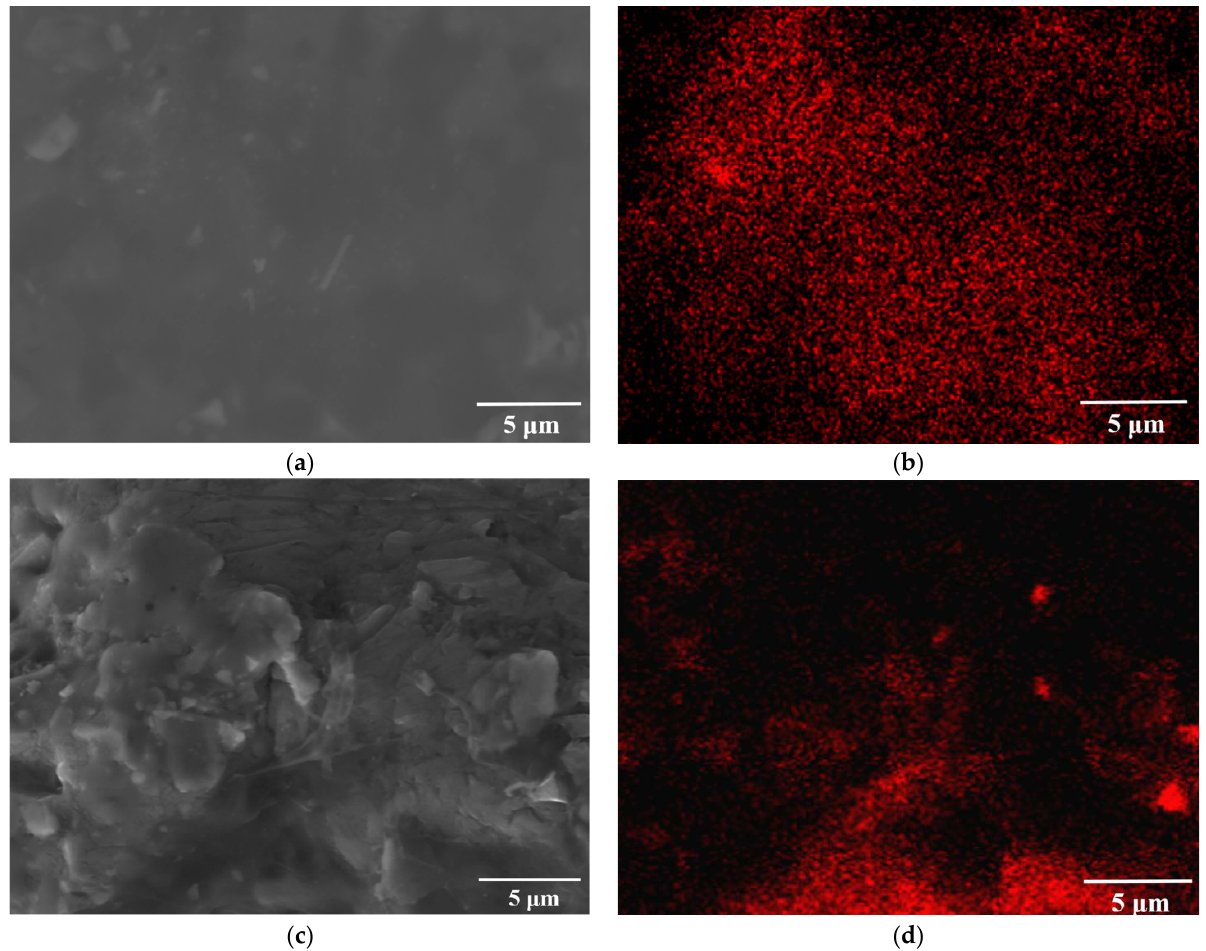
Figure 5. Secondary electron and backscattered electron image of Al-20TiC-0.3G composites before and after HCPEB treatment: ( a ) initial sample; ( b ) element distribution of C; ( c ) 15-pulse-treated sample; ( d ) element distribution of C.